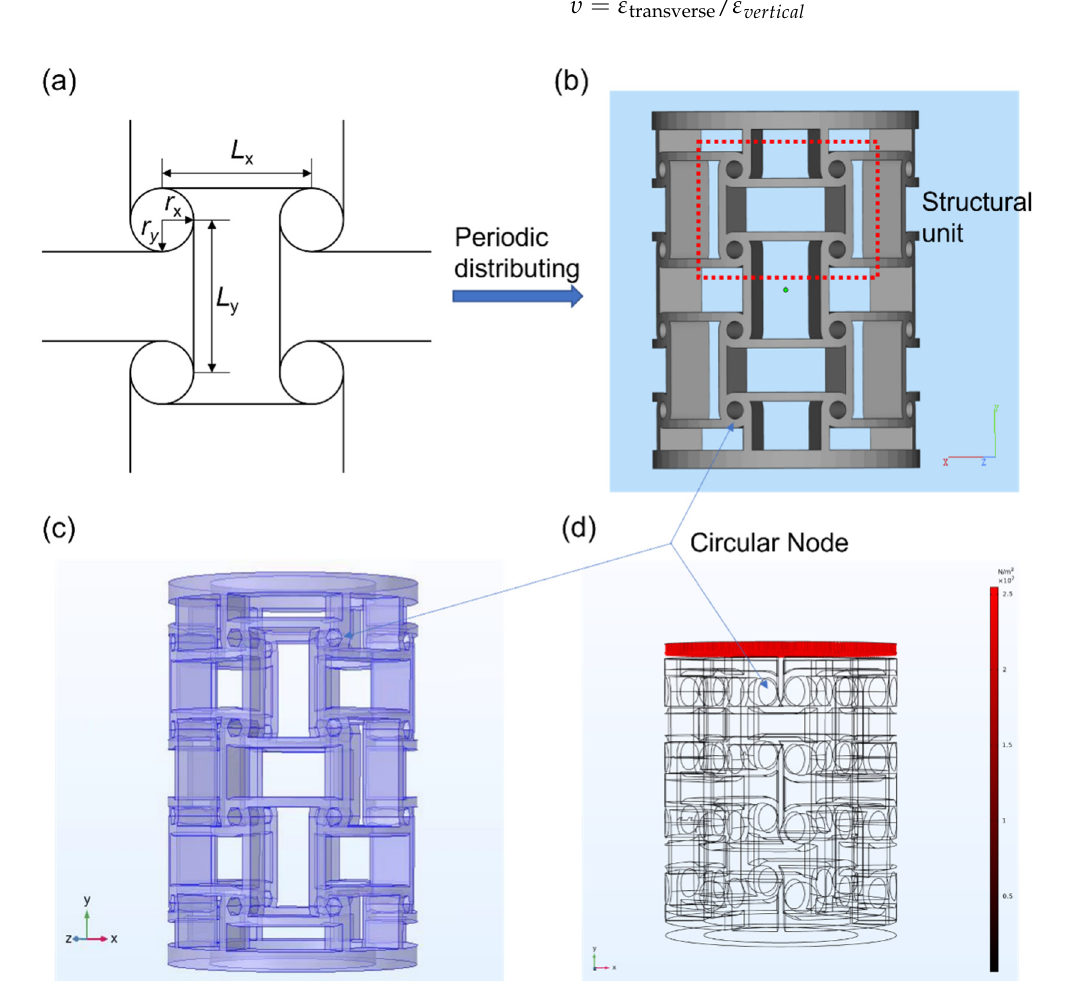
Figure 1. ( a ) Effect of node radius on Poisson’s ratio at the same displacement distance; ( b ) three- dimensional model of anisotropic anti-tetrachiral; ( c ) three-dimensional model in FEM software; ( d ) schematic diagram of boundary